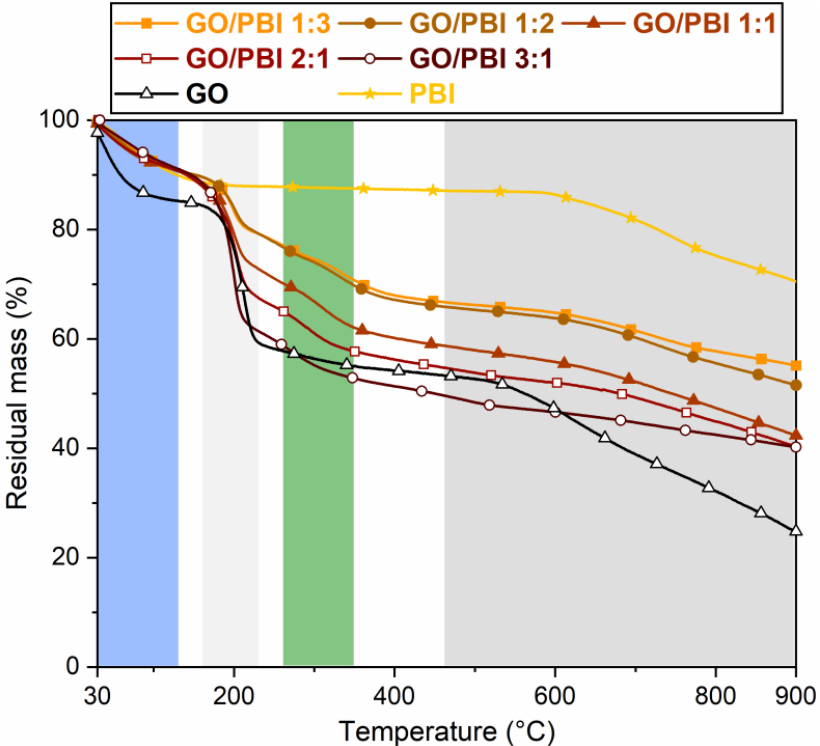
Figure 5. Thermograms of the GO/PBI X:Y composites, pure GO, and pure PBI membranes.